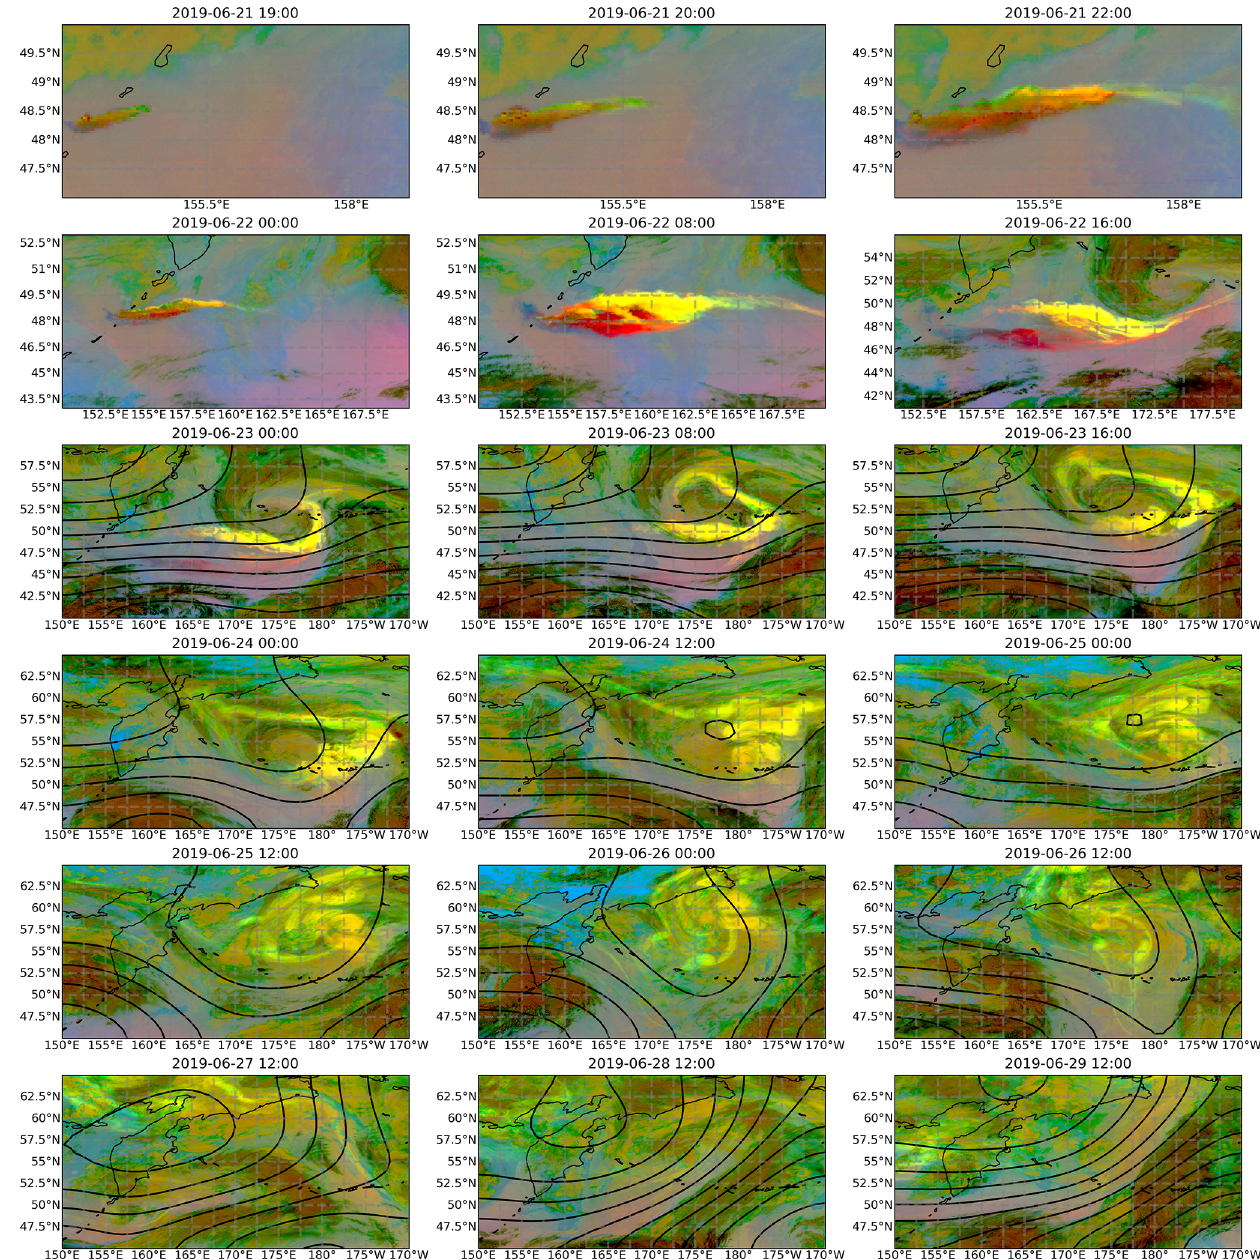
Figure 2. Himawari Dust RGB images from 21 June 2019 to 28 June 2019, over the region of Raikoke. Red: ash; bright green: SO 2 ; yellow: mixture of SO 2 and thin ash; greenish: thick and thin mid-level clouds or cirrus clouds; brown: thick and high ice clouds; blue: humid low- level air; pink to violet: dry low-level air. The contour lines are plotted for the Montgomery potential on the potential temperature surface 340K and indicate the mean atmospheric circulation. The image frame is expanded from the first panel to the last to follow the dispersion of the